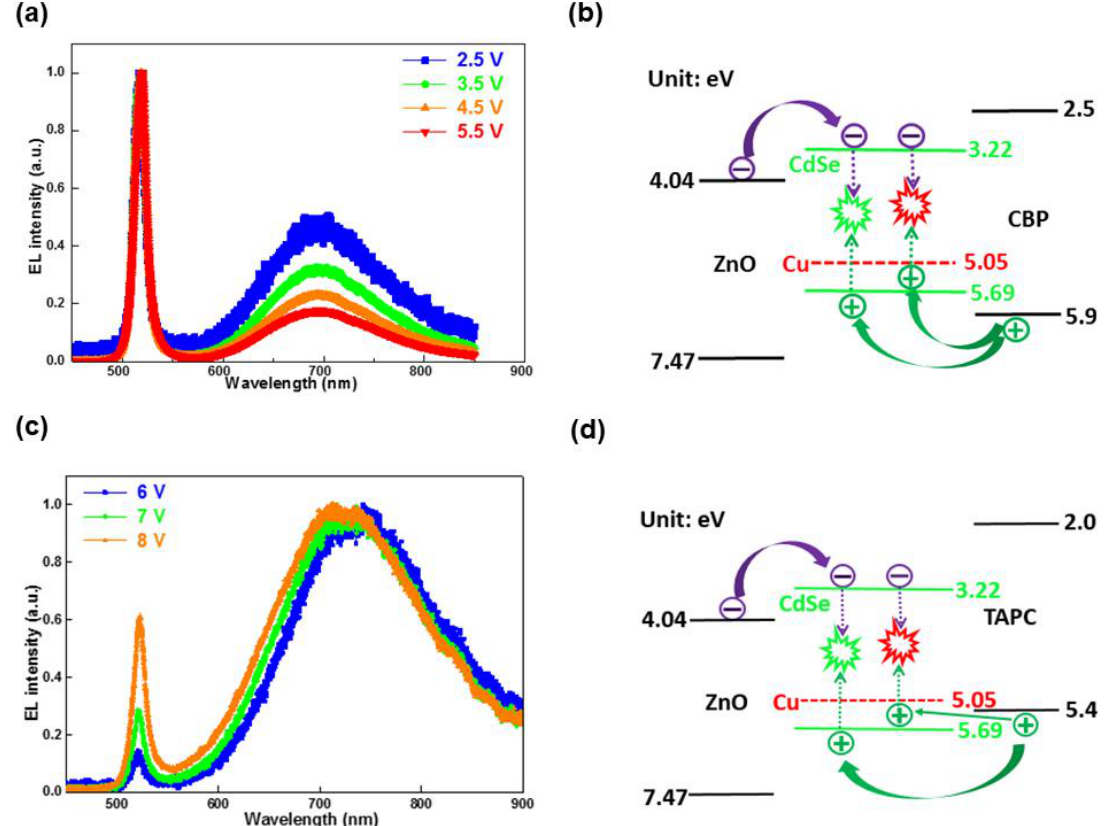
Figure 10. ( a ) EL spectra at various voltages, and ( b ) emission mechanism for CQW-LEDs with 0.5% Cu-doped concentration (CBP HTL). ( c ) EL spectra at various voltages, and ( d ) emission mechanism for CQW-LEDs with 0.5% Cu-doped concentration (TAPC HTL). Reproduced from reference [72].